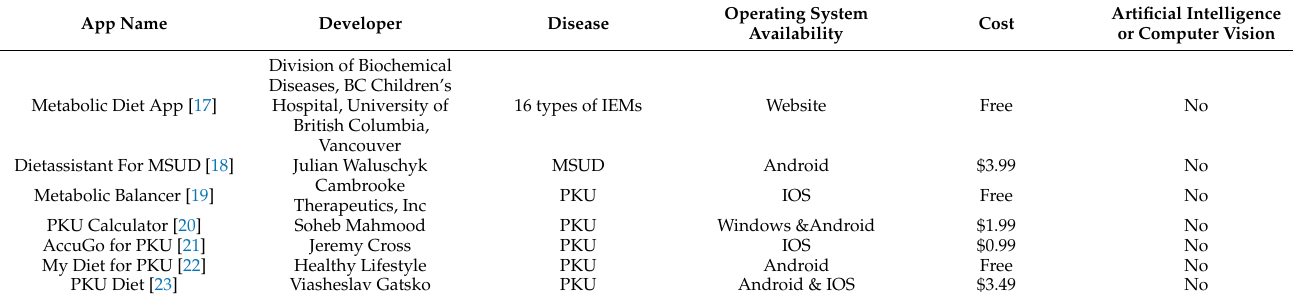
Table 1. Summary of most relevant applications that assist IEM